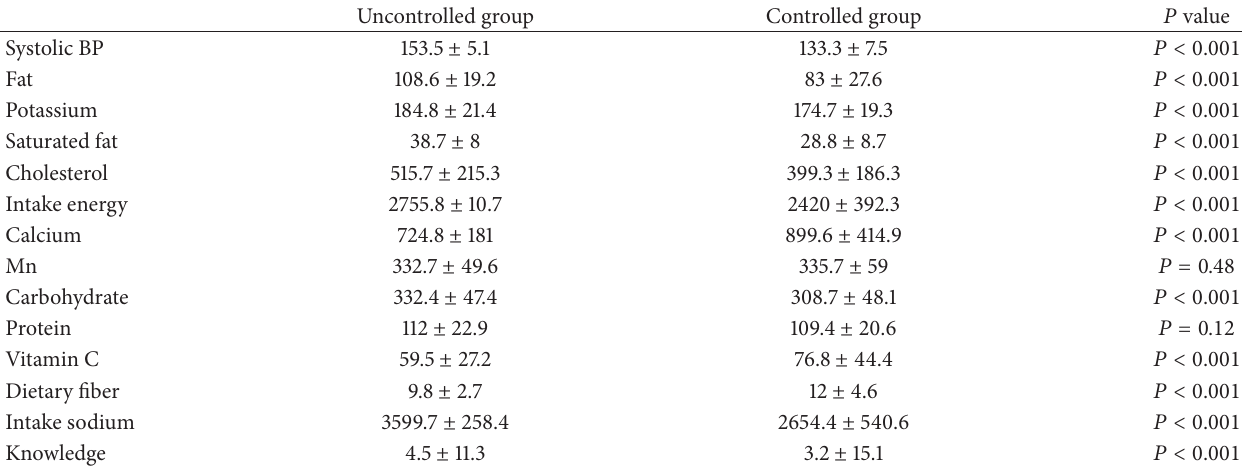
Table 2: Mean blood pressure and dietary factors in two groups of patients with